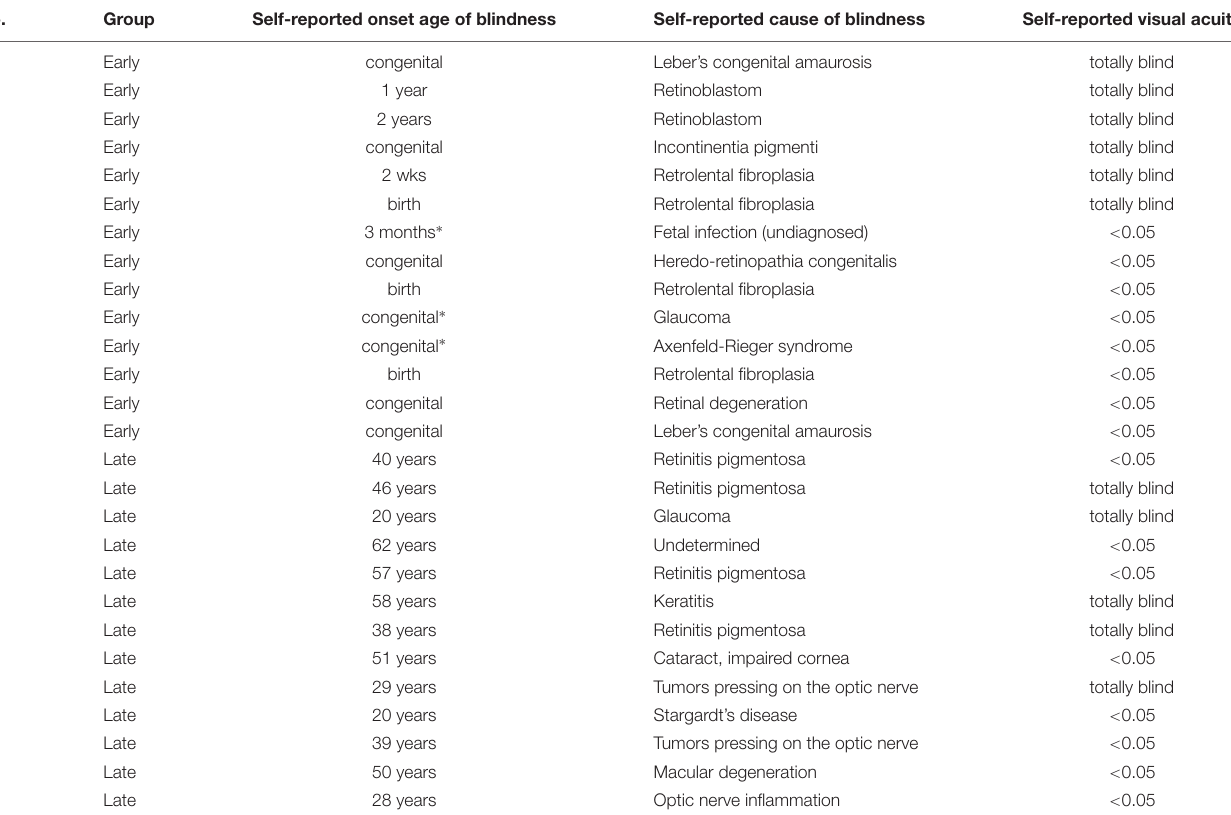
TABLE 1 | Blind participants’ group belonging and self-reported onset age of blindness, cause of blindness, and current visual acuity.